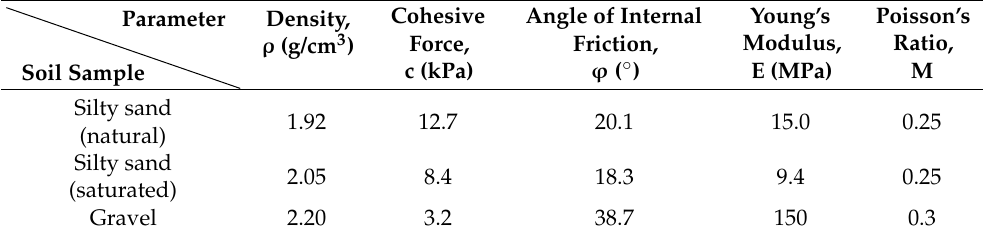
Table 1. Related parameters of test soil.